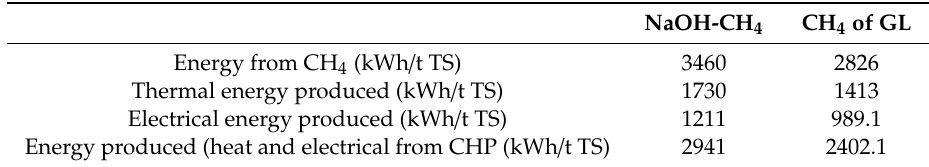
Table 3. Energy analysis for CH 4 production from the alkaline pretreated GL (NaOH-CH 4 ) and for untreated GL waste (CH 4 of